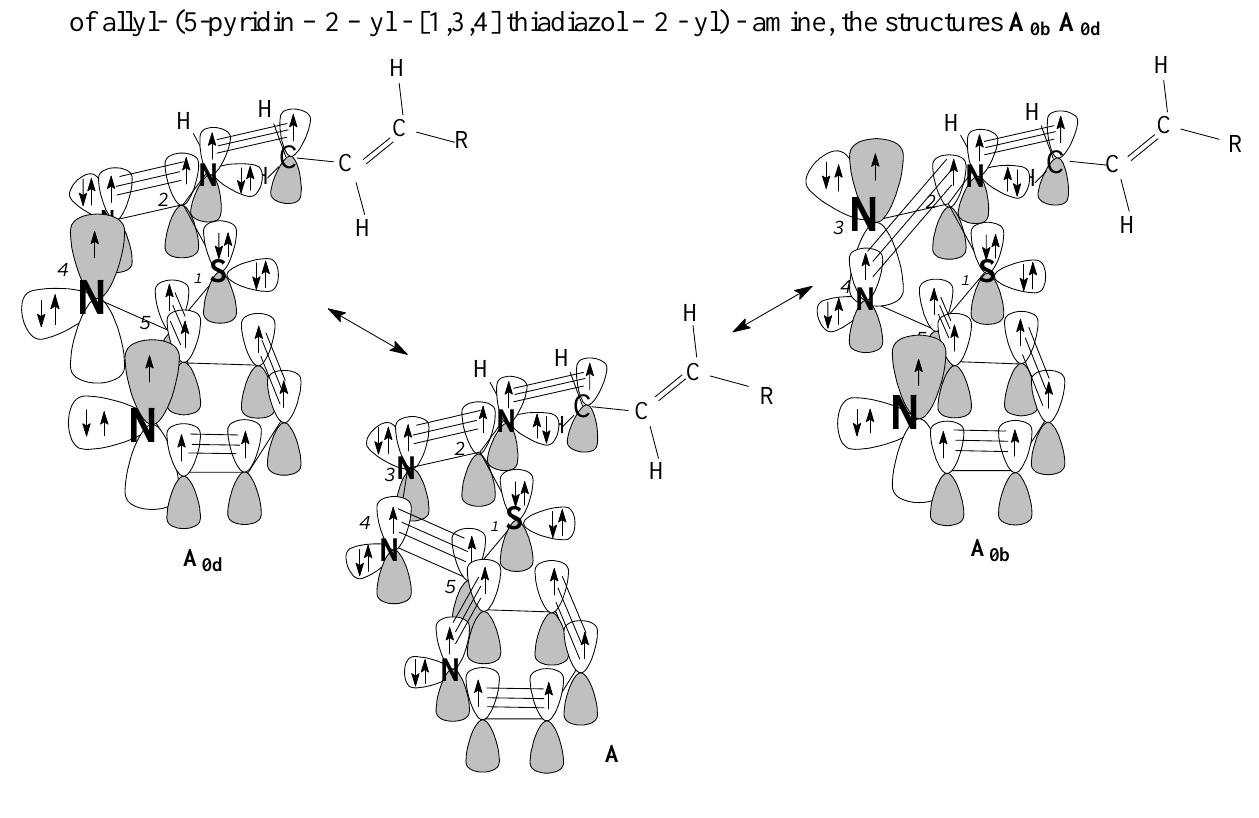
Figure 11 . The changes of the electron configuration of N3 N10 and N4 N10 nitrogen atoms of allyl- (5-pyridin – 2 – yl - [1,3,4] thiadiazol – 2 - yl) - amine, the structures A